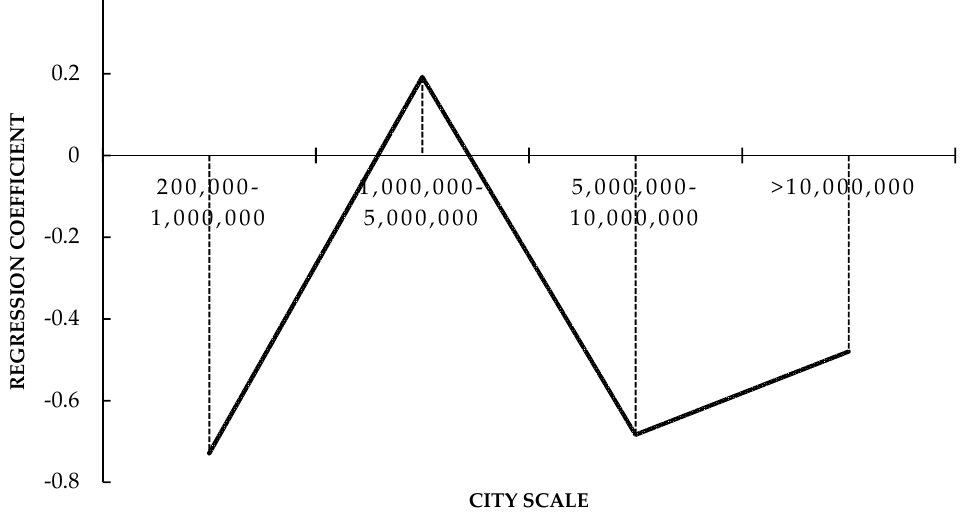
Figure 3. Trend of the regression coefficients for the direct effect with different city scales. Cities with the smallest population scale are most sensitive to the effects of the HSR connection.